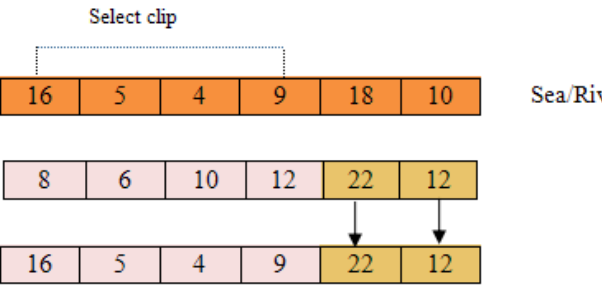
Figure 4. Third type of confluence update.